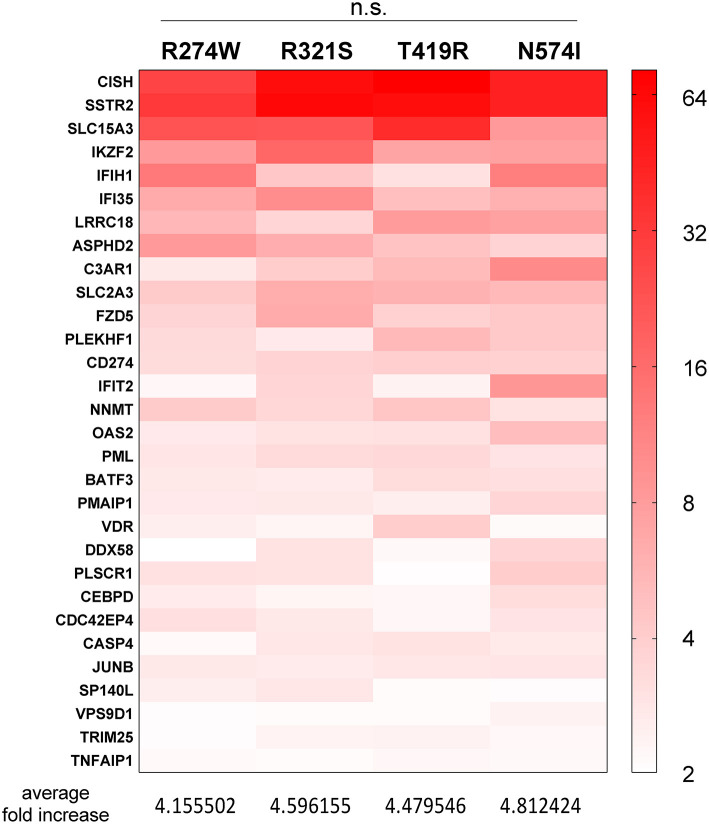
Heatmap representing the expression level of genes, present in the red part in Figure 2D, commonly up-regulated in all STAT1 GOF samples but not in STAT1 WT, after IFNγ stimulation. Expression level is represented as fold increase compared to unstimulated condition as different shades of red (see scale bar at the right-hand side of the figure). Below the heatmap, the respective average increases in fold expression are reported for the respective columns. Statistical analysis indicated on top: Two-way ANOVA with Dunnett's multiple comparison test, comparing each group to each other: n.s. not significant.